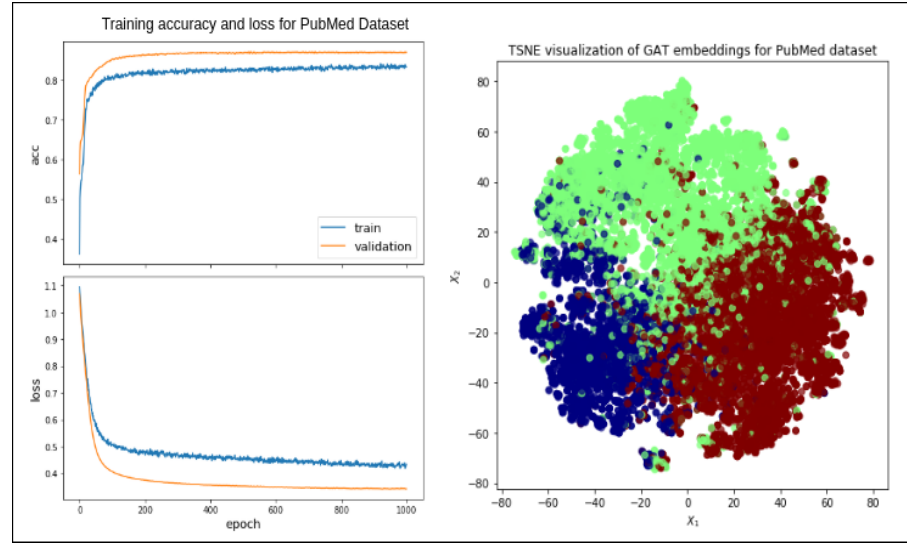
Figure 9. Graphical representation for PubMed dataset.